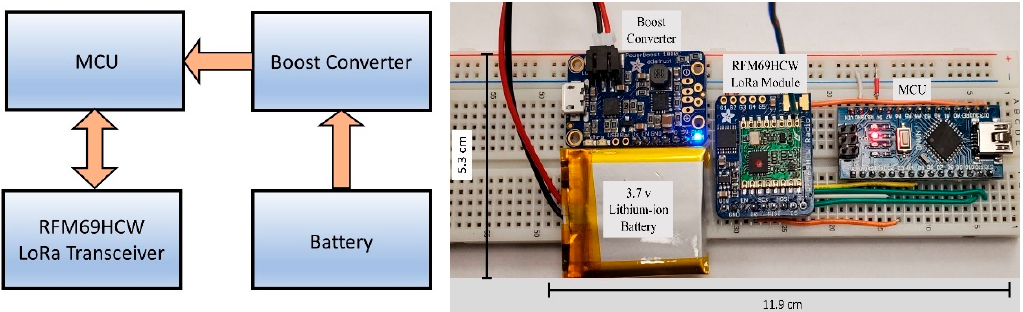
Figure 5. Architecture and prototype of the RSU.